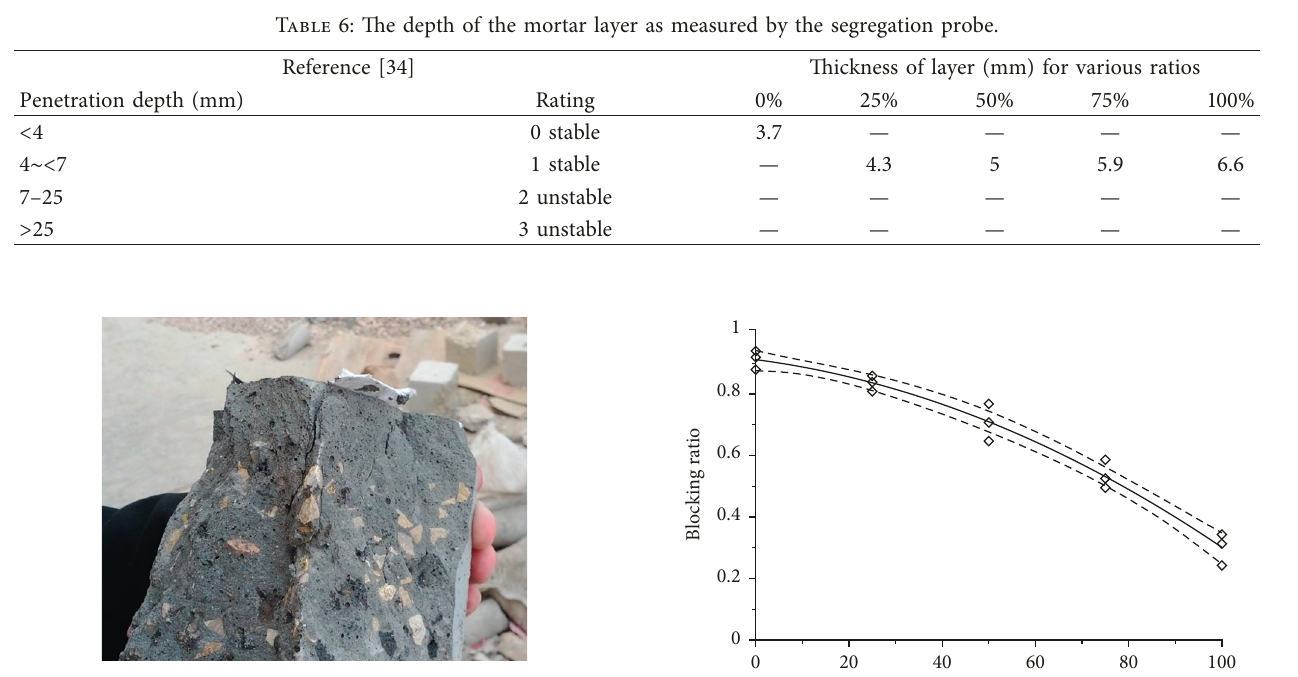
Figure 6: A sample of notable segregation.